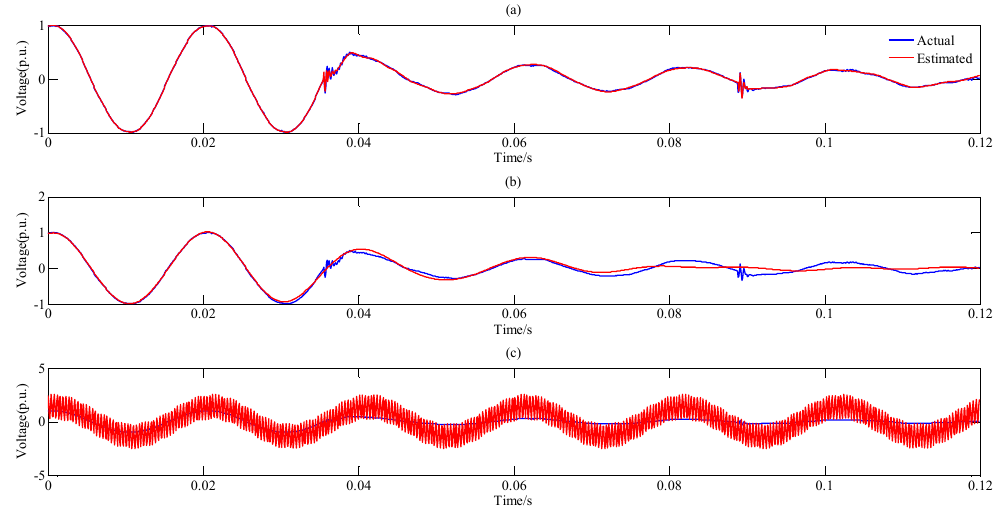
Figure 12. Source signal from IEEE PES Database and the reconstruction by using ( a ) The proposed method; ( b ) TLS-ESPRIT; ( c ) Prony method.